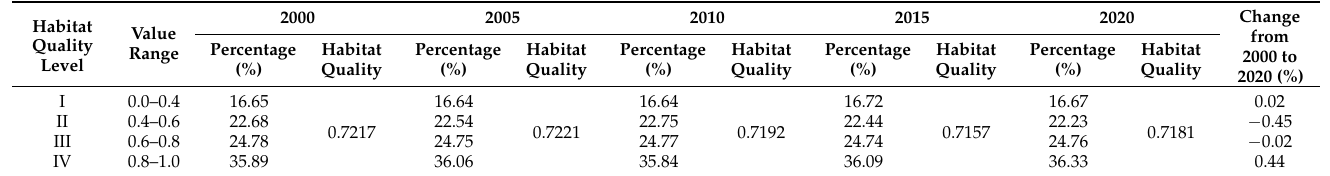
Table 4. Habitat quality change in Shiyan from 2000 to 2020.